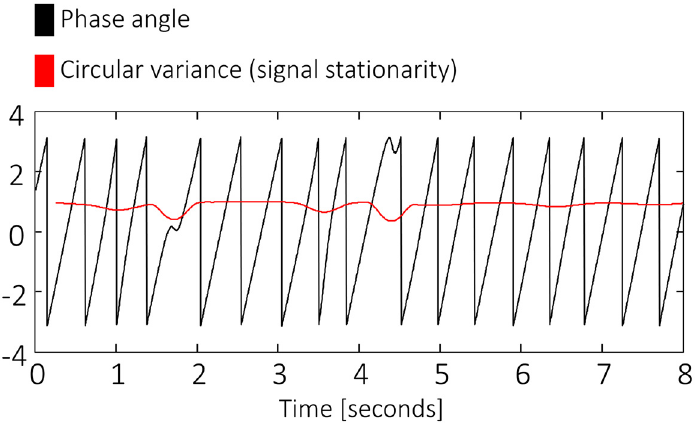
Fig 7. Circular variance within a sliding window of one cycle as a measure of signal stationarity. When the signal is stationary and there are no phase resets, the circular variance reaches